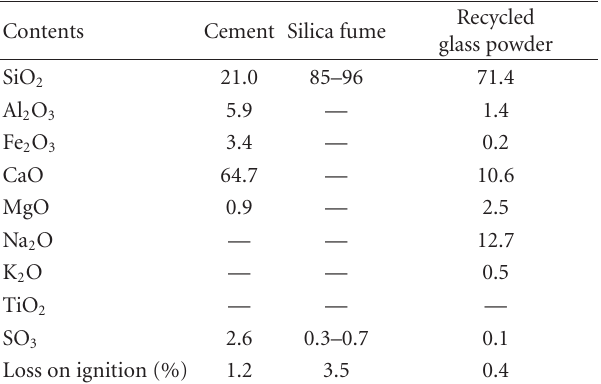
Table 1: Chemical composition of cement, recycled glass powder, and silica fume.